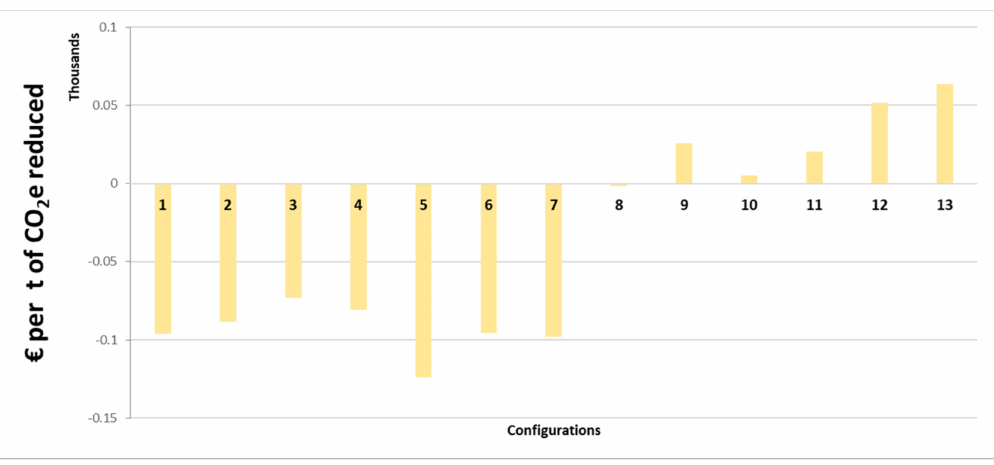
Figure 6. Cost-benefit analysis results for the Aframax tanker